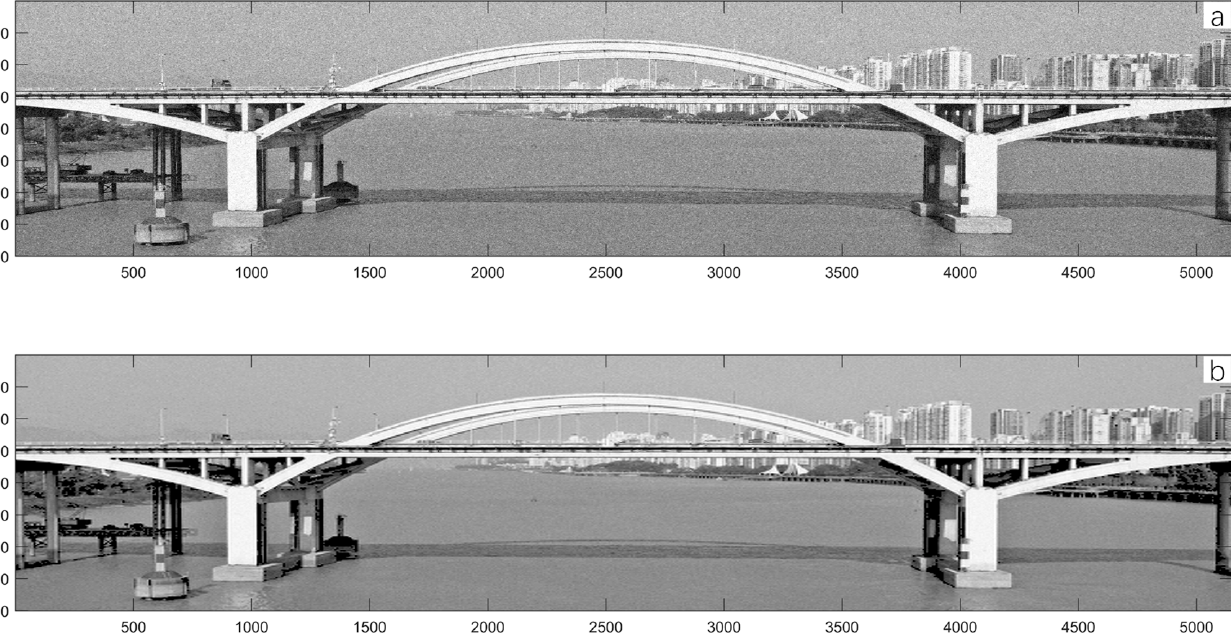
Figure 6. Image denoising: ( a ) noise-laden images; ( b ) denoised images.